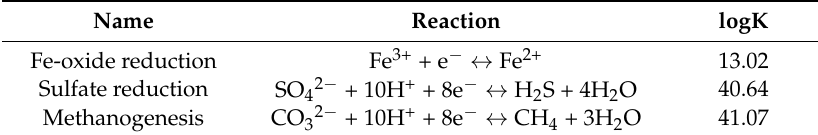
Table 2. Stoichiometry of TEAP reactions implemented in Model